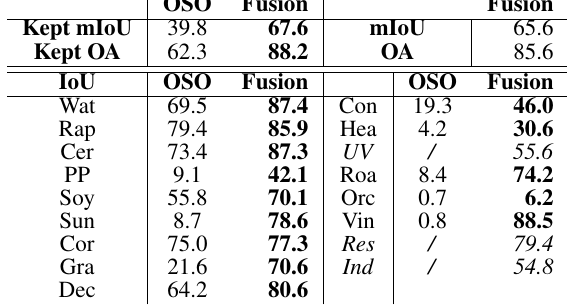
Figure 5. Rows : (1) Road network overview, (2) Countryside area, (3) Industrial and commercial area. Columns : (a) SPOT image, (b) Ground truth, (c) OSO map, (d) Reclassification inference, (e) Fusion inference Kept